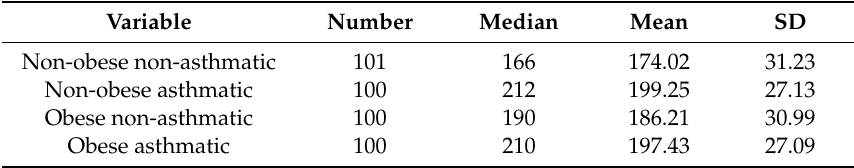
Table 1. Ghrelin level among di ff erent groups of